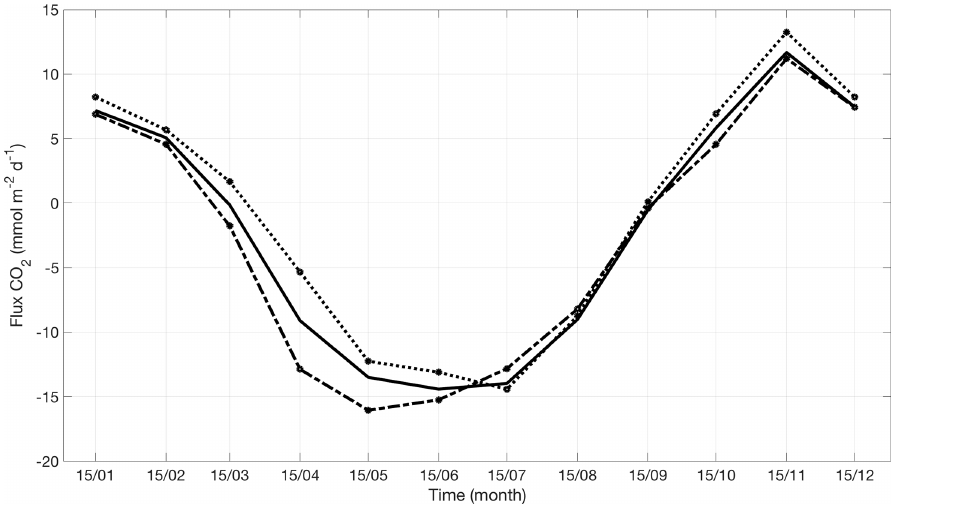
Figure 7. Seasonal cycle of air–sea CO 2 flux for the Baltic Sea. The solid line represents the average for the full period (1998–2011). The dotted line with a marker is for the first 5 years (1998–2002) and the dashed line is for the last 5 years (2007 to 2011).